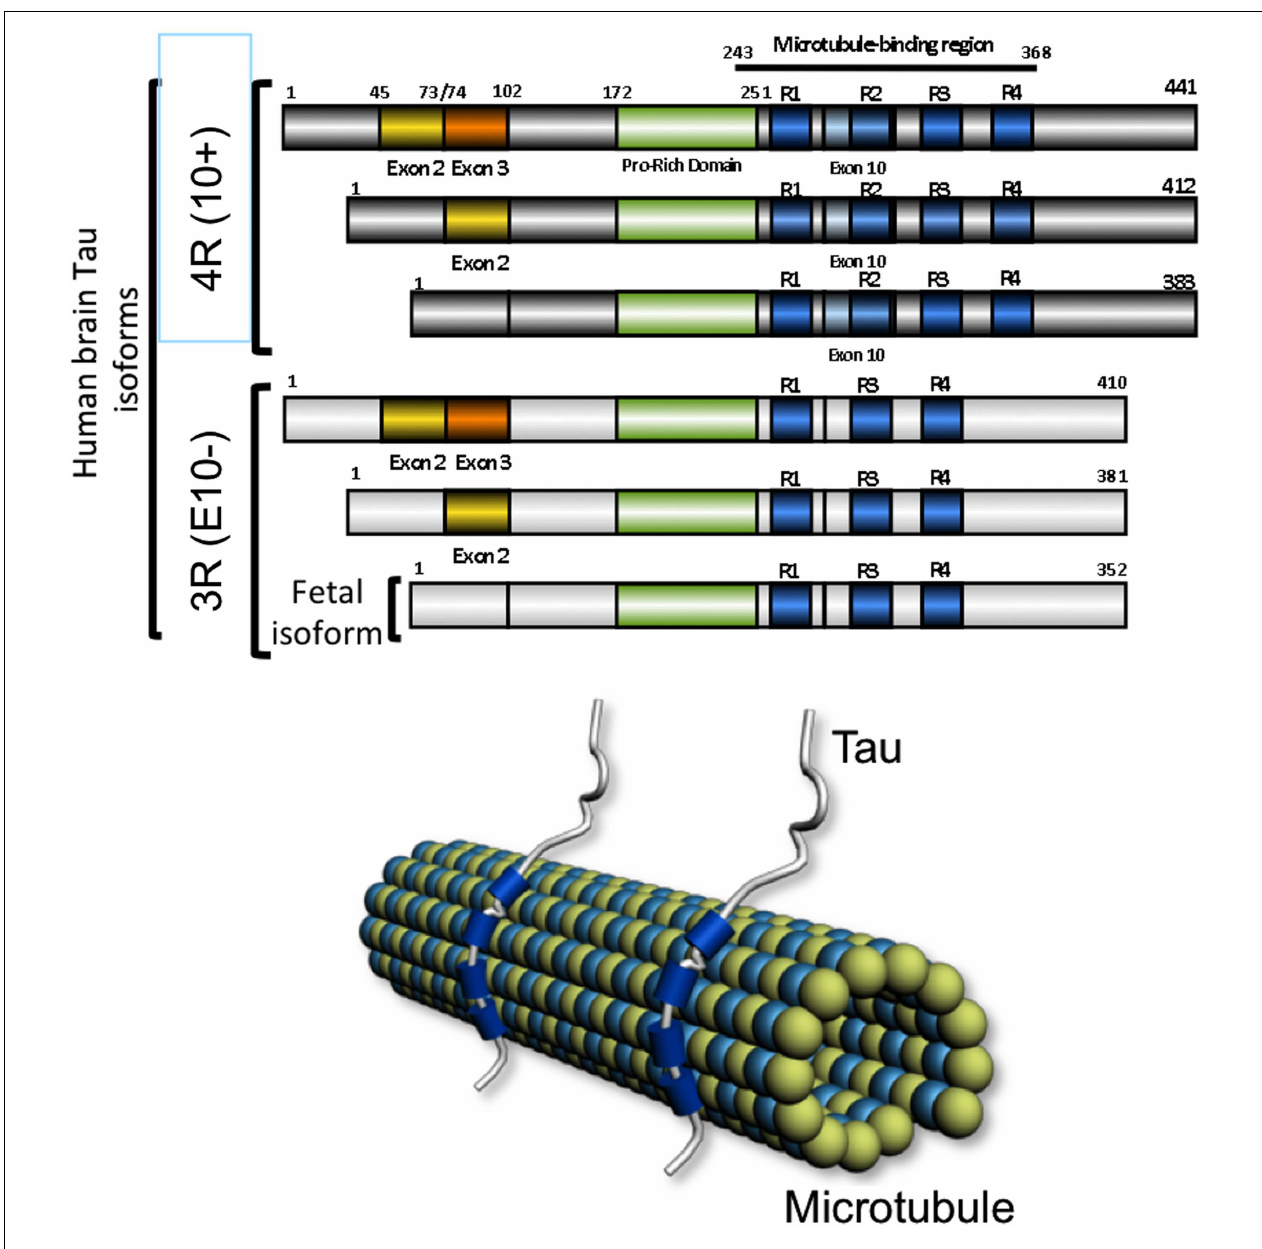
inclusion of exon 10 there are tau isoforms with 4 (4R) or 3 (3R) microtubule-binding regions.The fetal isoform is lacking the alternative encoding cassettes 2, 3, and 10.Tau protein binds the microtubule lattice through its microtubule-binding domains shown in